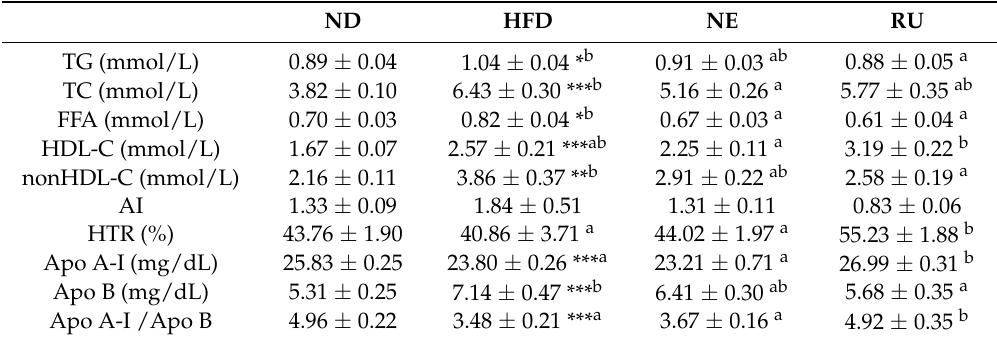
Table 2. Effect of NE and RU supplementation for 16 weeks on plasma lipid profiles in C57BL/6J mice fed high-fat diet.